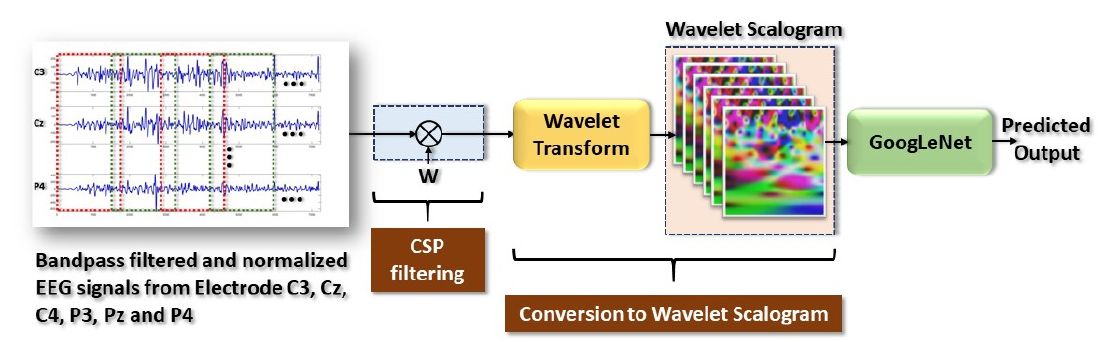
Figure 3. General framework for classification of EEG motor function data using CSP and